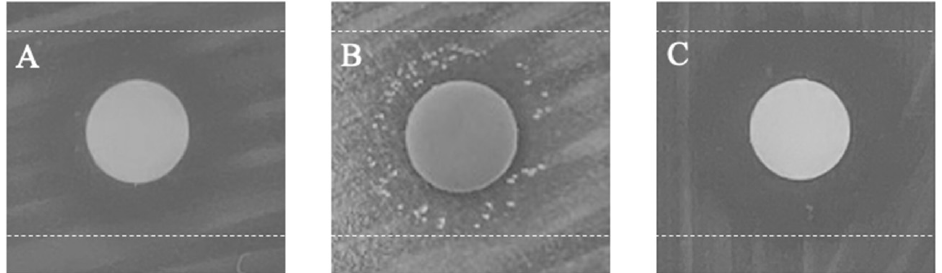
Figure 2. Follow-up TD test of tolerant colonies. ( A ) Zone of inhibition after step I of the TD test with 0.008 µg CRO. ( B ) Zone of inhibition after step III of the TD test. ( C ) Re-exposure of picked tolerant colonies to 0.008 µg CRO. Dashed lines mark the zone of inhibition, 6 mm discs.